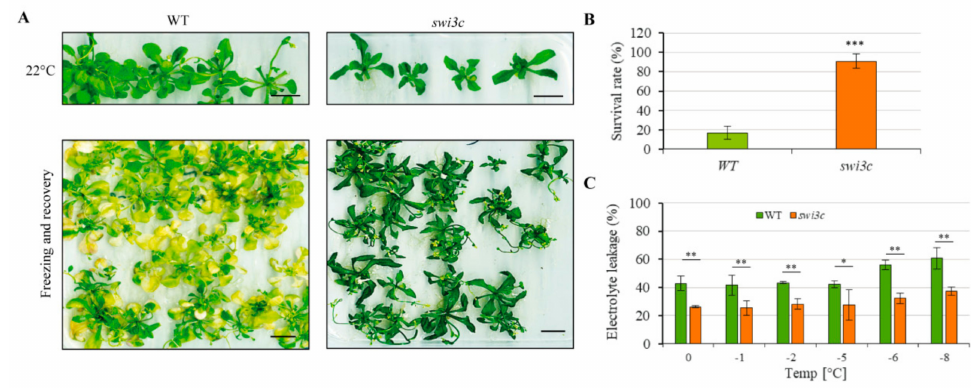
Figure 4. The swi3c Mutant Exhibits Enhanced Freezing Tolerance. ( A ) swi3c plants are more tolerant to freezing than wild type control. Upper panel: 3-weeks old WT and swi3c plants grown on plates under long day conditions. Lower panel: WT and swi3c plants exposed to freezing and subsequently recovered for seven days under long day conditions at 22 ◦ C. ( B ) The survival rate of wild type and swi3c plants subjected to freezing tolerance assay indicate enhanced freezing tolerance of swi3c plants. ( C ) swi3c plants exhibit lower electrolyte leakage after freezing damage than WT plants further confirming their enhanced freezing tolerance. Asterisks indicate significant di ff erence from wild type (*): p < 0.05 ; (**): p < 0.01 (***): p < 0.001 according to t-test. Error bars refer to